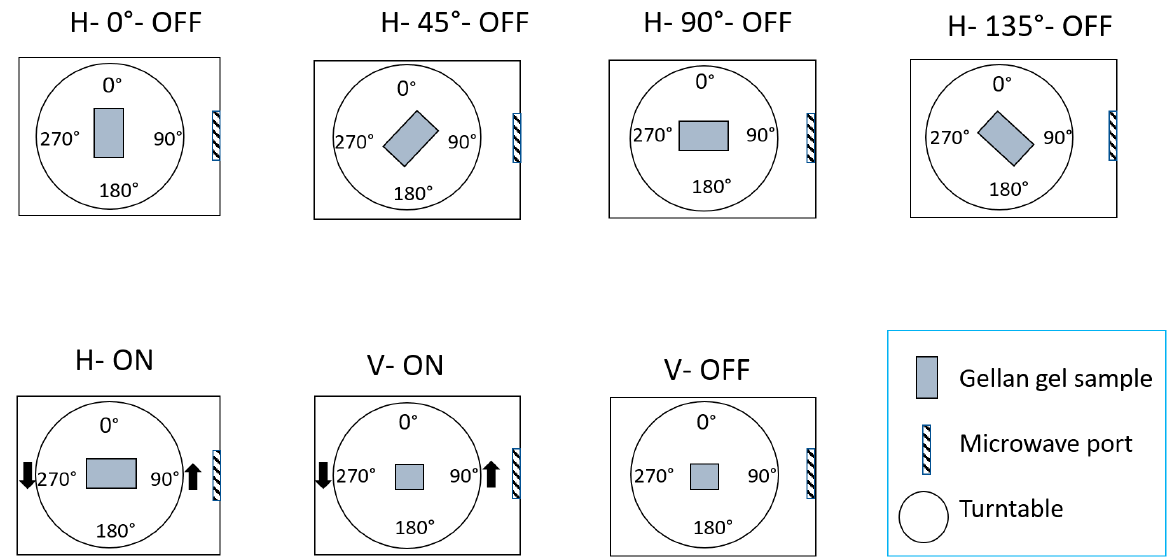
Figure 3. Seven investigated orientations in both the solid-state and magnetron microwave cavities. The abbreviations of V, H, ON, and OFF represent vertical orientation, horizontal orientation, turntable on, and turntable off, respectively.